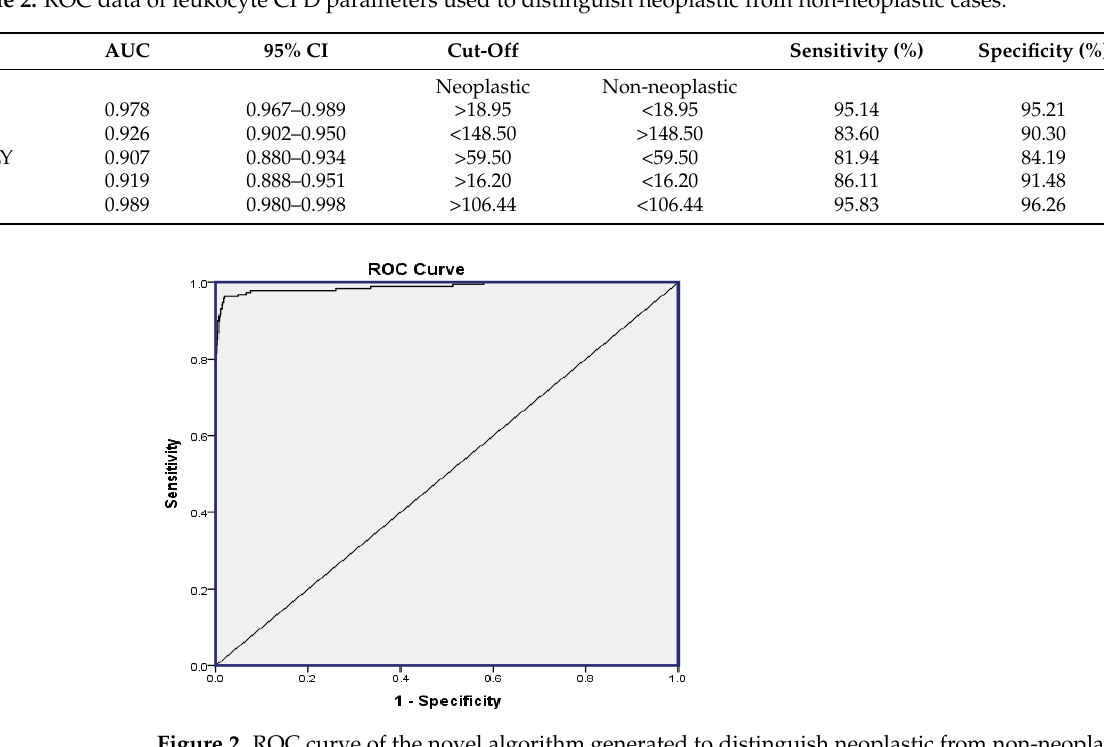
Figure 2. ROC curve of the novel algorithm generated to distinguish neoplastic from non-neoplastic cases: [(SD-V-NE*MN-UMALS-LY*SD-AL2-MO)/MN-C-NE] with AUC: 0.989; 95% CI: 0.980–0.998; Cut-off: 106.44; Sensitivity: 95.83%; Specificity: 96.26%.